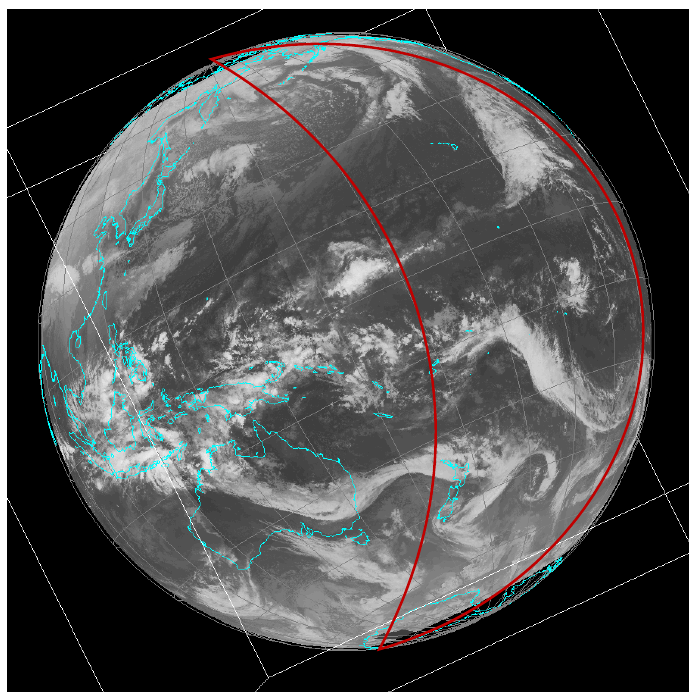
Figure 5. Infrared global geostationary composite v1 at UTC 2013/12/24 18:15 (from EarthData, https://earthdata.nasa.gov/).